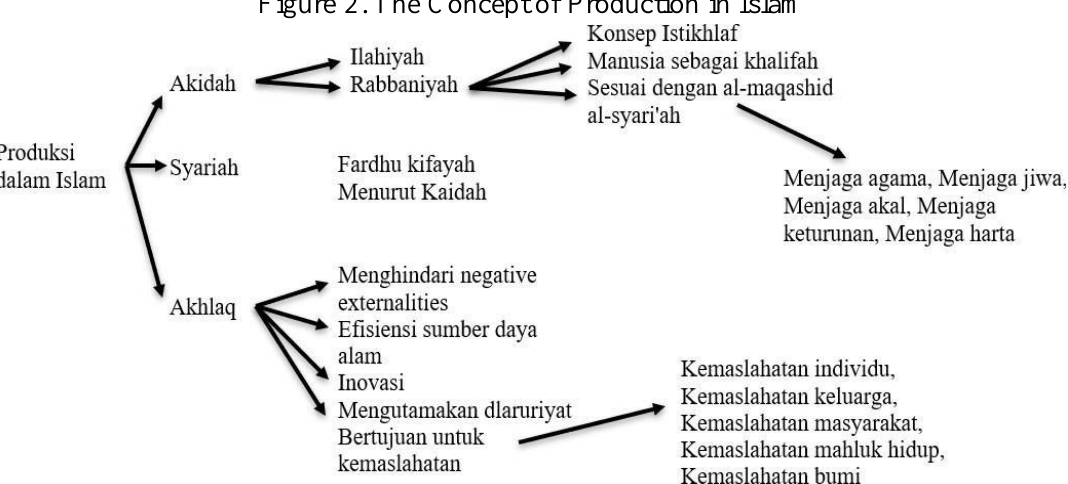
Figure 2. The Concept of Production in